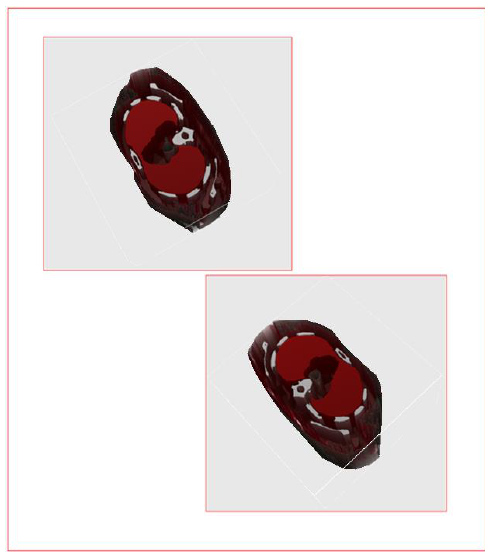
Figure 23. Volumetric visualization of chest and lung based on Figure 21.